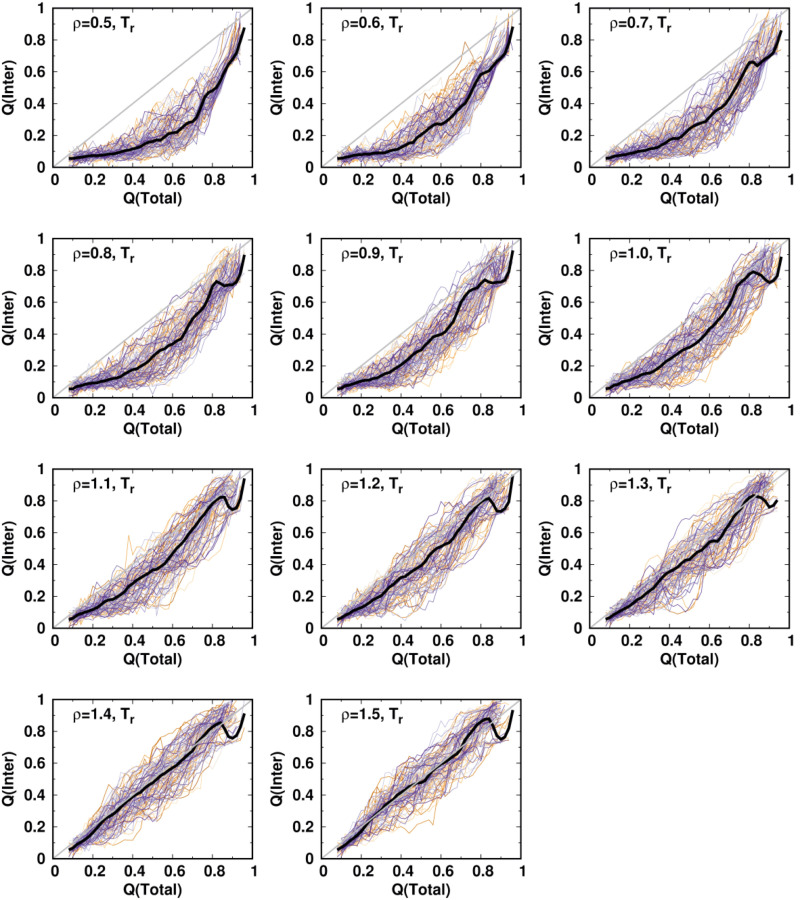
The averaged Q⁢(Inter) along with Q⁢(Total) at temperature Tr for different values of ρ.